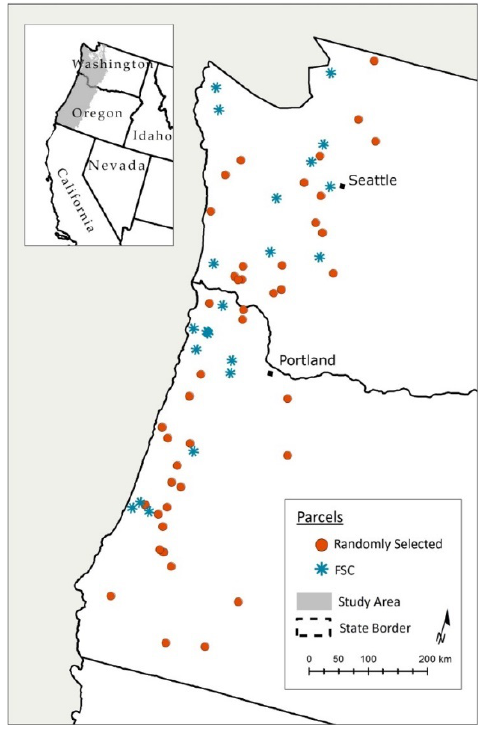
Figure 1. Study area. Actual FSC-certified parcels are distinguished from randomly selected parcels. All parcels are subject to the same suite of simulated management practices (both ~FSC and ~FPA scenarios). FPA: Forest Practices Act; FSC: Forest Stewardship Council.